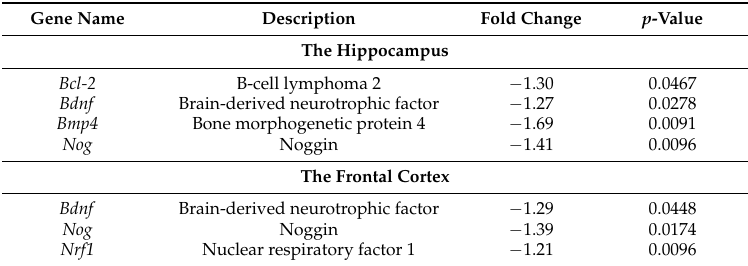
Table 1. The statistically significant differences in the relative gene expression between apoE − / − group vs. wild type animals in the hippocampus and the frontal cortex ( p < 0.05, n = 3).